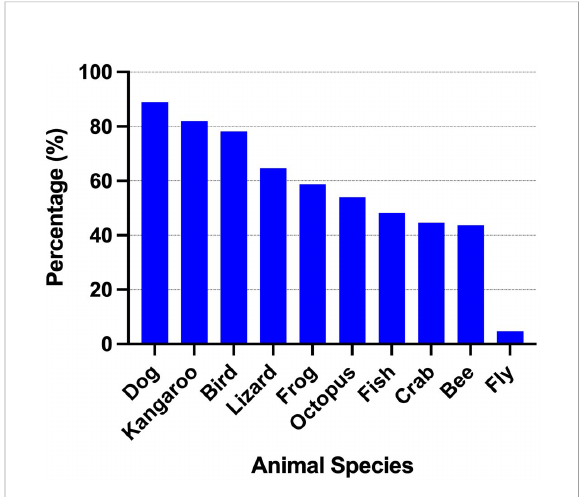
FIGURE 1 Percentage of respondents that believed named species should be awarded protection from cruelty. As multiple response options were available for participants, “ all the above ” responses were removed from the sample, giving a sample size of n=954. “ Which of the following species do you think should be protected from cruelty? ”